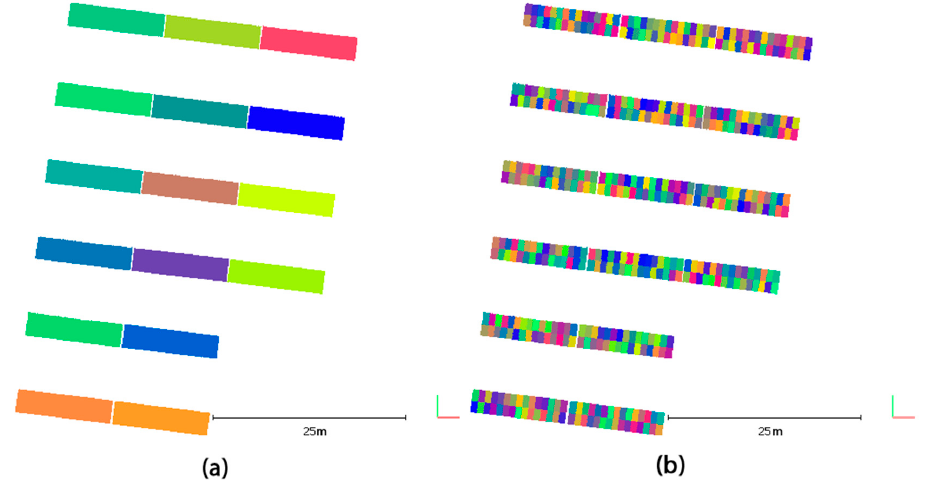
Figure 8. ( a ) Result of the extraction of PV panels cluster using the Euclidean cluster extraction algorithm. ( b ) Results of the extraction of each PV panel with the intensity-based algorithm. Table 4. PV Cluster parameters: IDs are defined in ascendant order from north to south and from west to east.